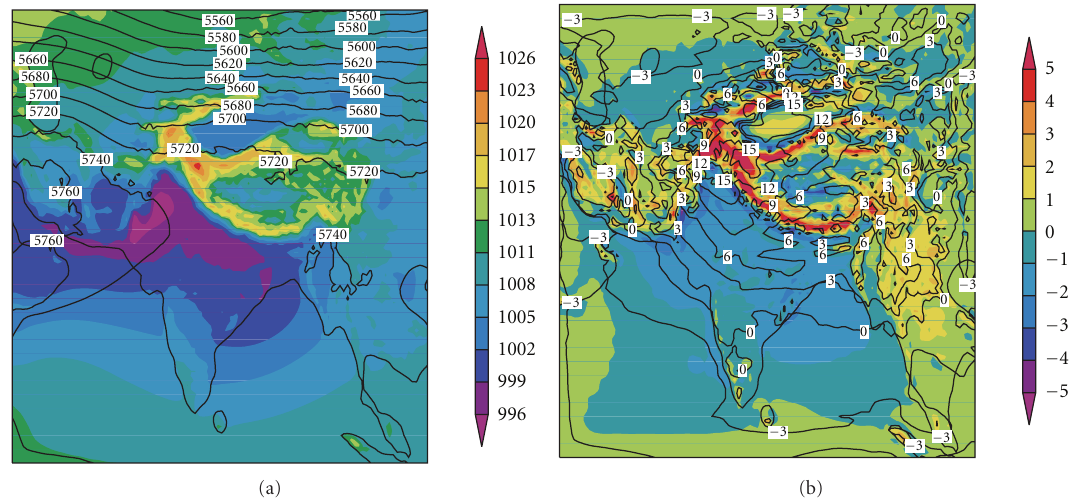
Figure 2: Mean sea level pressure (hPa; shaded) and geopotential height at 500hPa (gpm; contour lines) for HIRHAM (a) and the di ff erence “HIRHAM-ERA40” (b); summer monsoon (JJAS) 1958–2001.